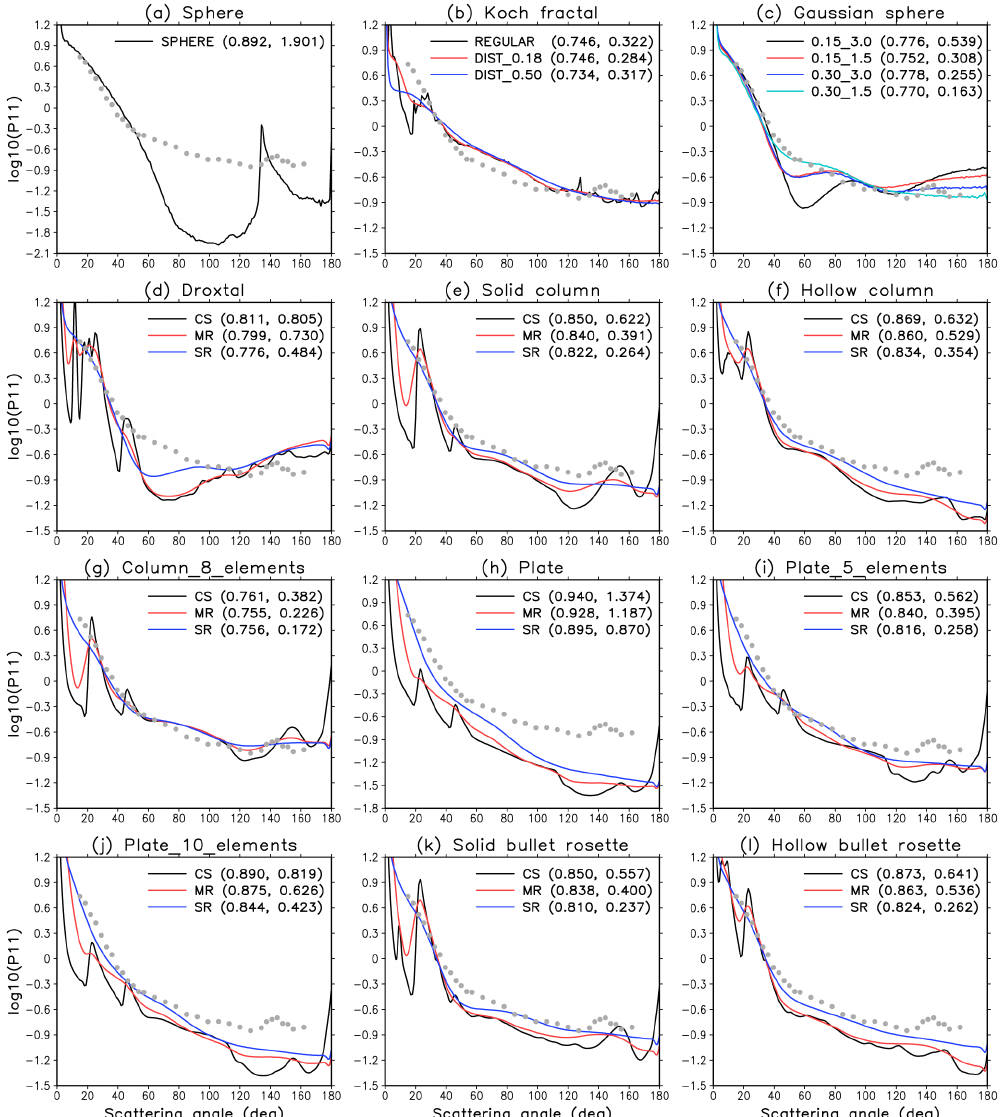
Figure 3. Comparison of phase function for various shape models with the reference phase function derived from CLIMSLIP data ( P ref shown with grey dots in each panel). (a) Spheres, (b) regular and distorted second-generation Koch fractals (with distortion parameters t = 0.18 and t = 0.50), (c) four realizations of Gaussian spheres and (d–l) nine habits in the Yang et al. (2013) database. For each habit, the phase function was averaged over the size distribution defined by Eq. (3). In the figure legends, the two numbers in parentheses give the asymmetry parameter and the cost function defined by Eq. (4) respectively. For the Gaussian spheres in (c) , the notation indicates the shape parameters (e.g. for 0.15_3.0, σ = 0.15 and ν = 3.0; n max was fixed at 15). For the Yang et al. (2013) habits in (d–l) , CS, MR and SR refer to particles with completely smooth surface, moderate surface roughness and severe surface roughness